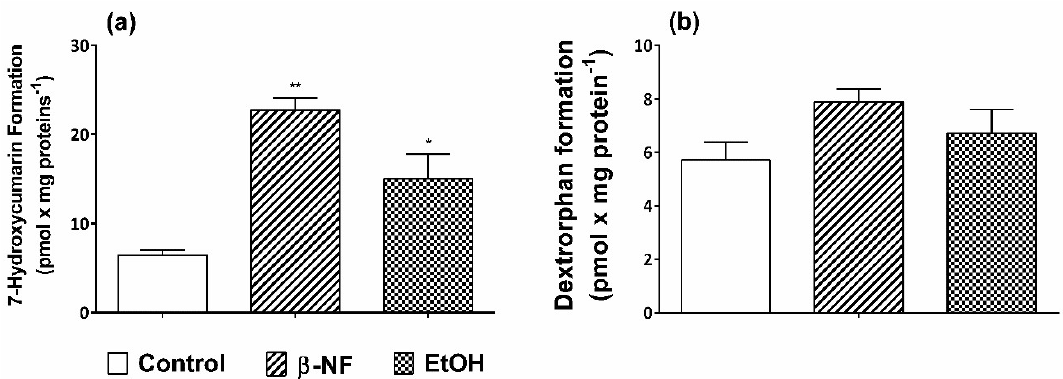
Figure 3. Treatment with β -NF and EtOH increase the metabolic activity of CYP(s) in undifferentiated SH-SY5Y cells. Cells were incubated for 48 h with β -NF and EtOH and were subsequently treated for 24 h with either 7-ethoxycoumarin (50 µ M) or dextromethorphan (50 µ M). ( a ) 7-Ethoxycoumarin dealkylase activity in SH-SY5Y cells is increased after treatment with inducers. 7-Hydroxycoumarin was determined spectrofluorimetrically by an excitation of 370 nm and emission of 455 nm. ( b ) Dextrorphan formation in β -NF- and EtOH-treated cells. Each column represents the metabolite formation (dextrorphan) and was determined by HPLC–MS analysis. Results are expressed as mean ± SEM of three different cell preparations. * p < 0.05; ** p < 0.01.